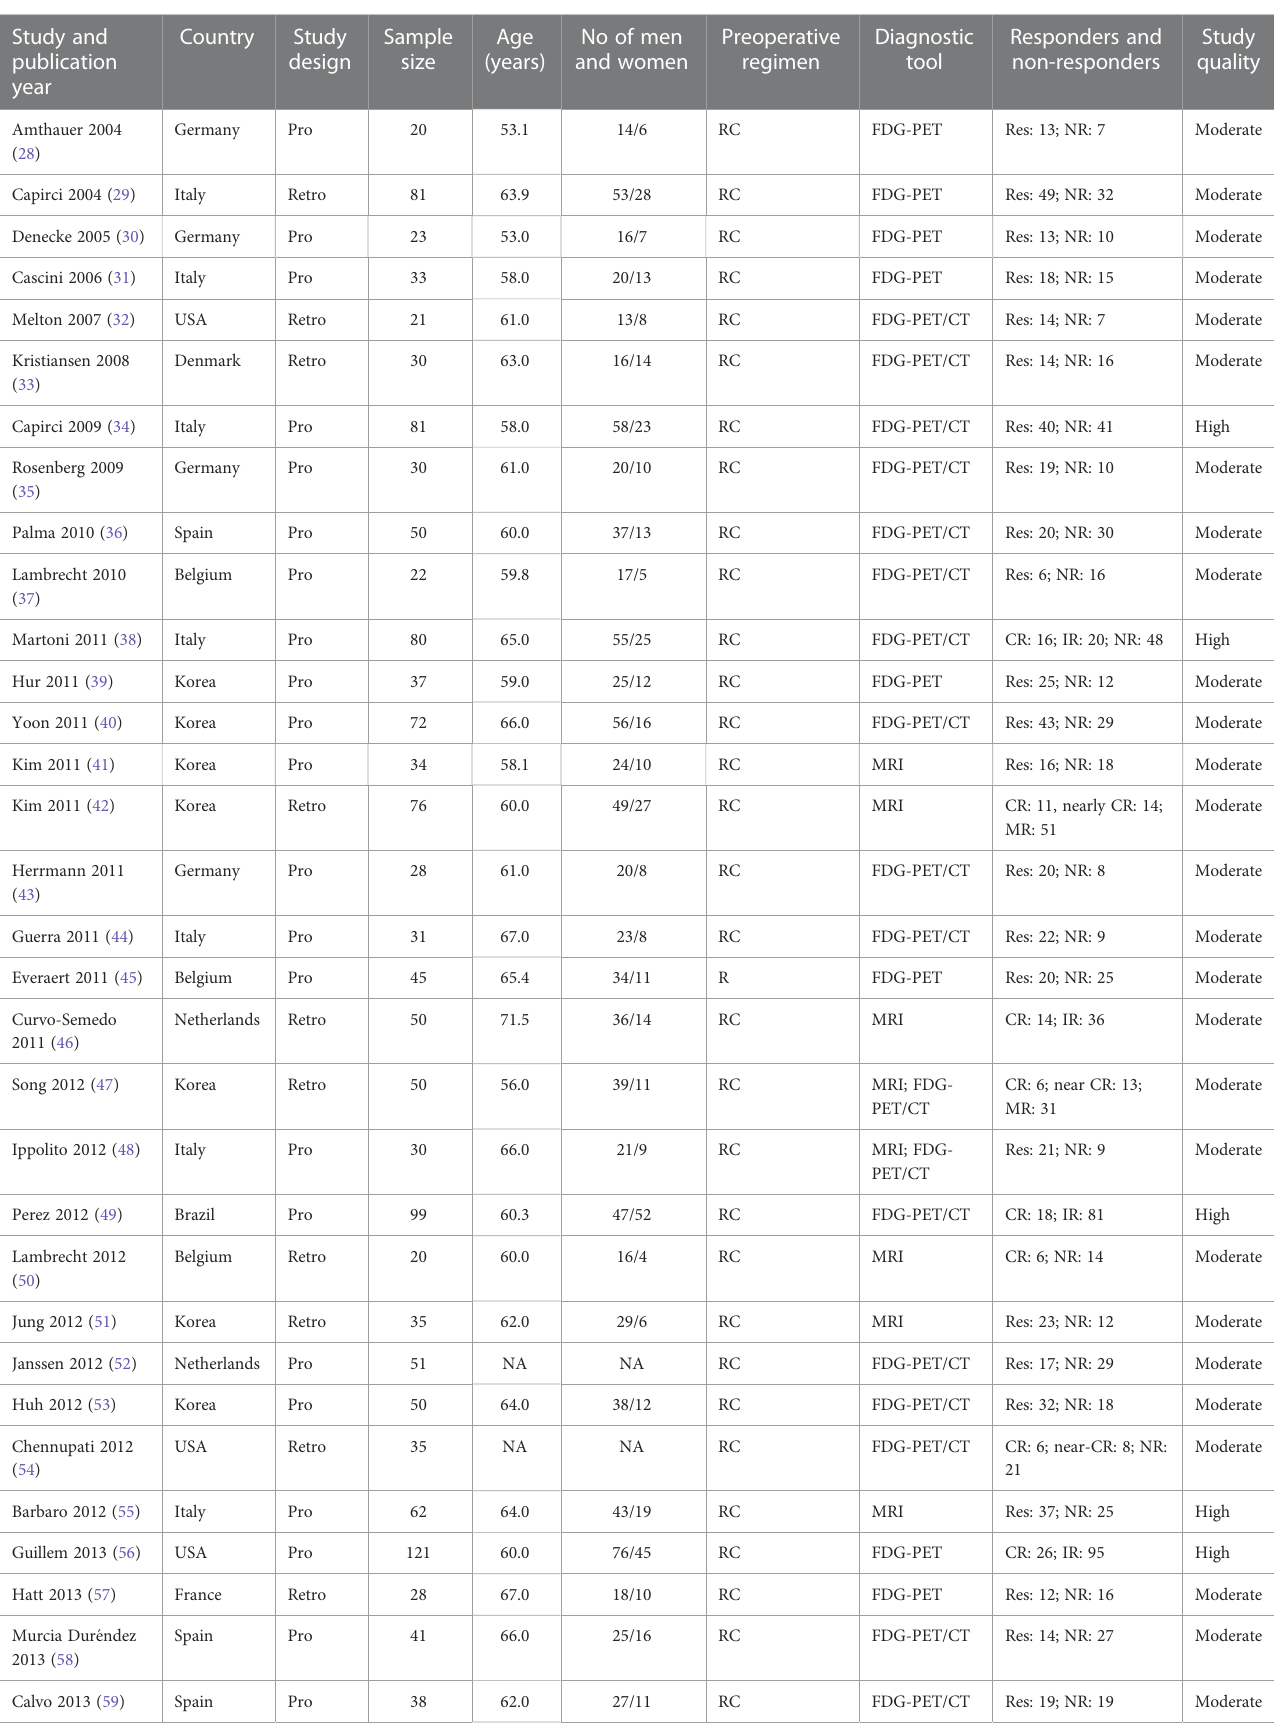
TABLE 1 The baseline characteristics of included